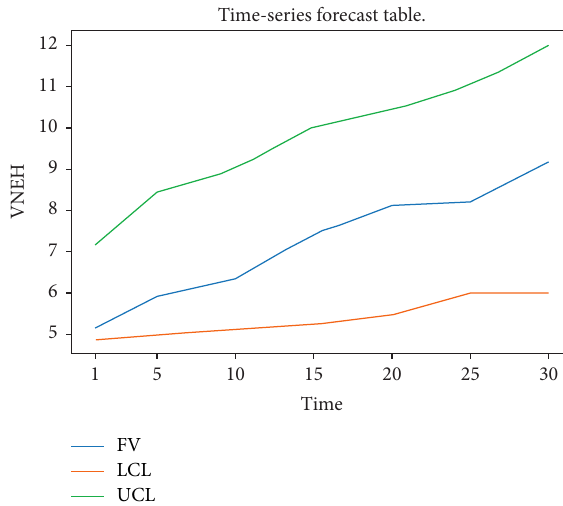
Figure 6: Time-series forecast